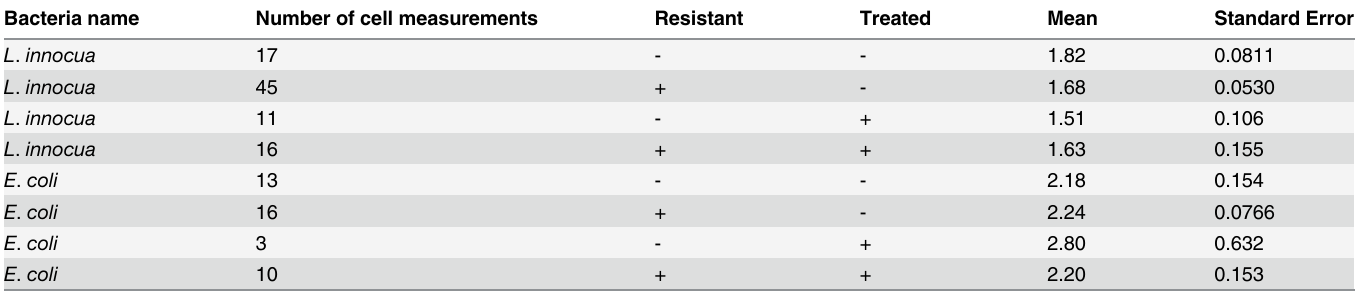
Table 1. Cell length measurements of resistant and non-resistant strains of E . coli MG1655 and L . innocua field strain exposed and non-exposed to AgNP and BAC